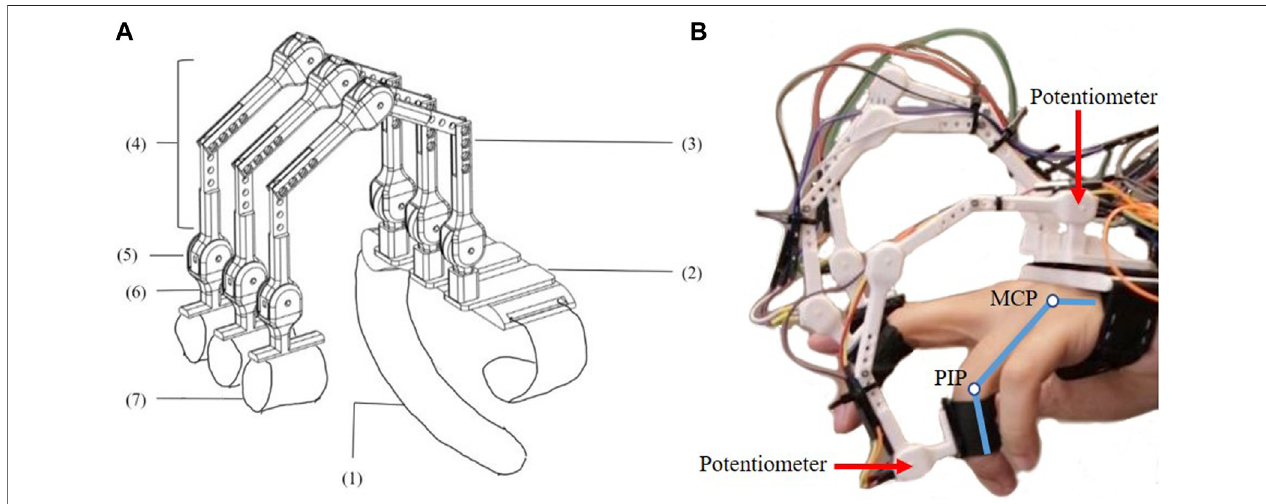
FIGURE4| GloveoneisdesignedforJointAngleMapping(JAM) (A) Thedesignconsistsof(1)Elasticband(2)3Dprintedbase.(3)3DprintedFingerSegment1.(4) 3D printed Finger Segment 2. (5) Linear Rotary Potentiometer (PT10MH01-103A2020-S, 10 k Ω , 0.15W) (6) 3D printed fi nger attachment support (7) Finger Straps (B) The user wears the glove to measure MCP and PIP fl